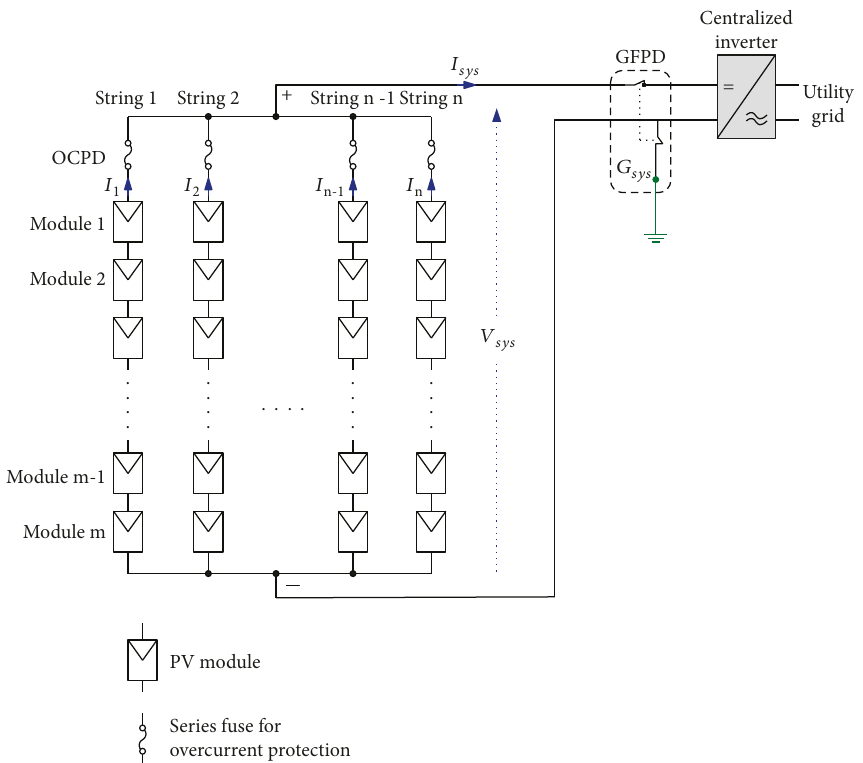
Figure 1: Typical grid-connected PV array with a centralized